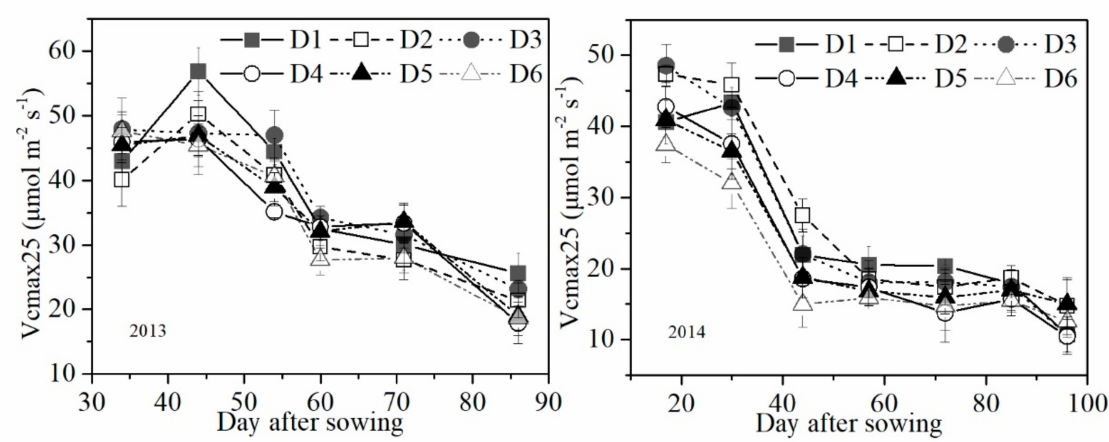
Figure 2. Vcmax25 changes with the development process of drought during 2013 and 2014.